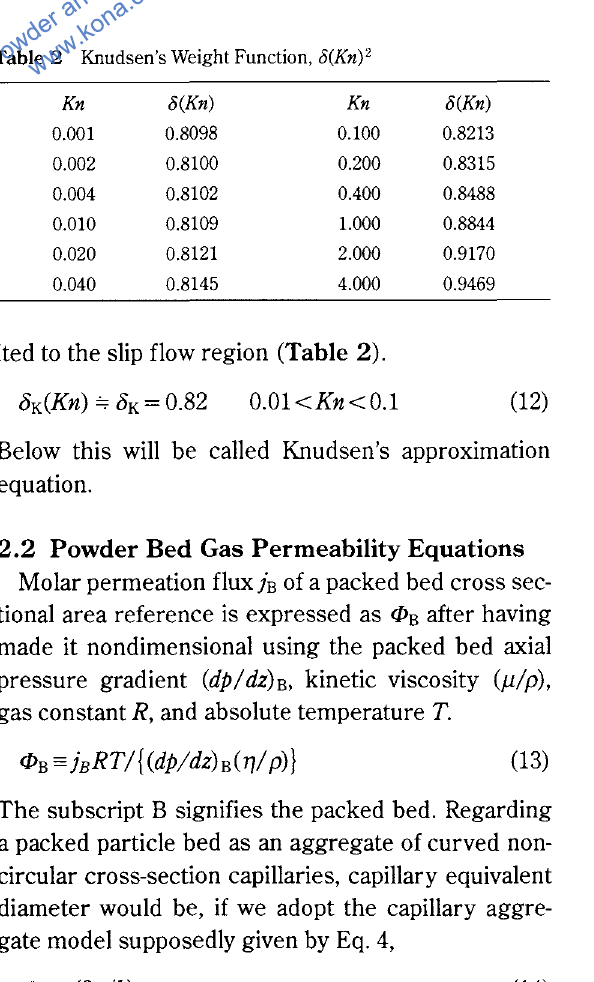
Table 2 Knudsen's Weight Function, i5(Kn)